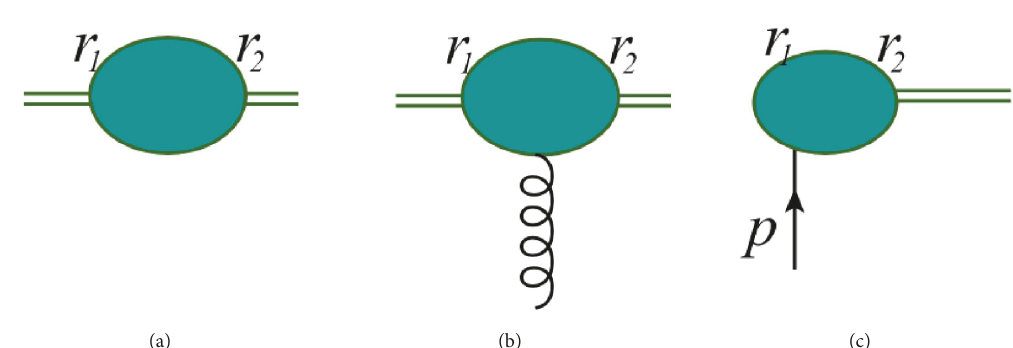
Figure 7: Topologies that may lead to UV divergent contributions to the quark quasi-PDFs. Source: [134], reprinted with permission by the Authors and the American Physical